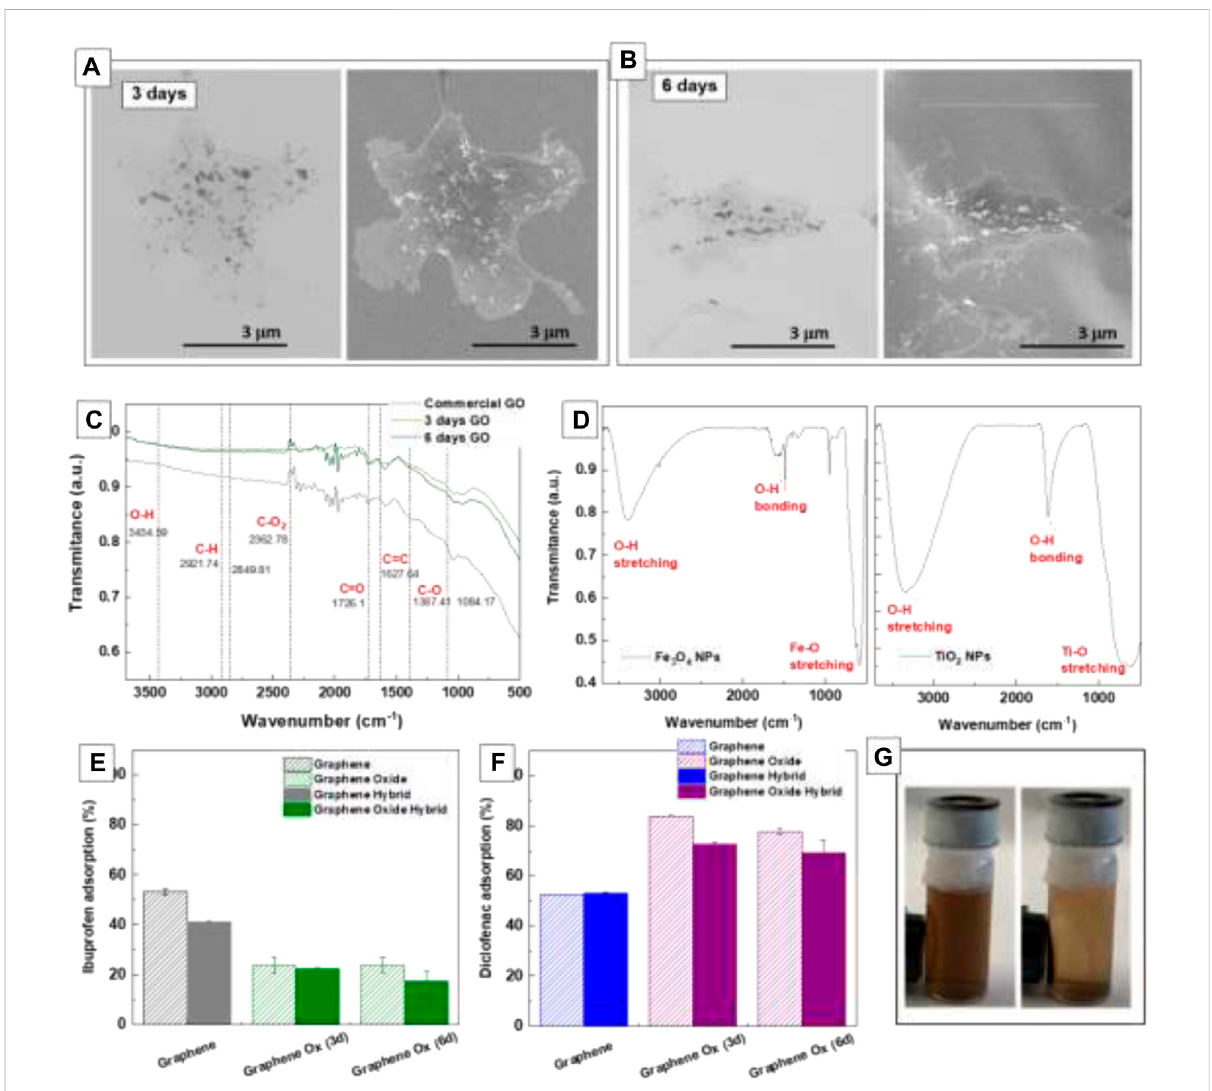
FIGURE 6 Transmission and Scanning Electron Microscopy of the Fe 3 O 4 /Graphene Oxide hybrid after 3 days (A) and 6 days (B) of oxidation under acidic conditions.FT-IRoftheusedgrapheneoxide (C)